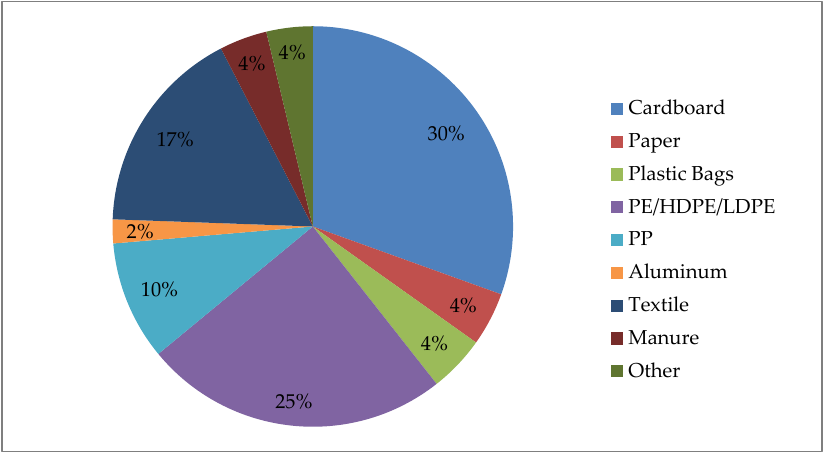
Figure 3. Albanian participants waste type profile.